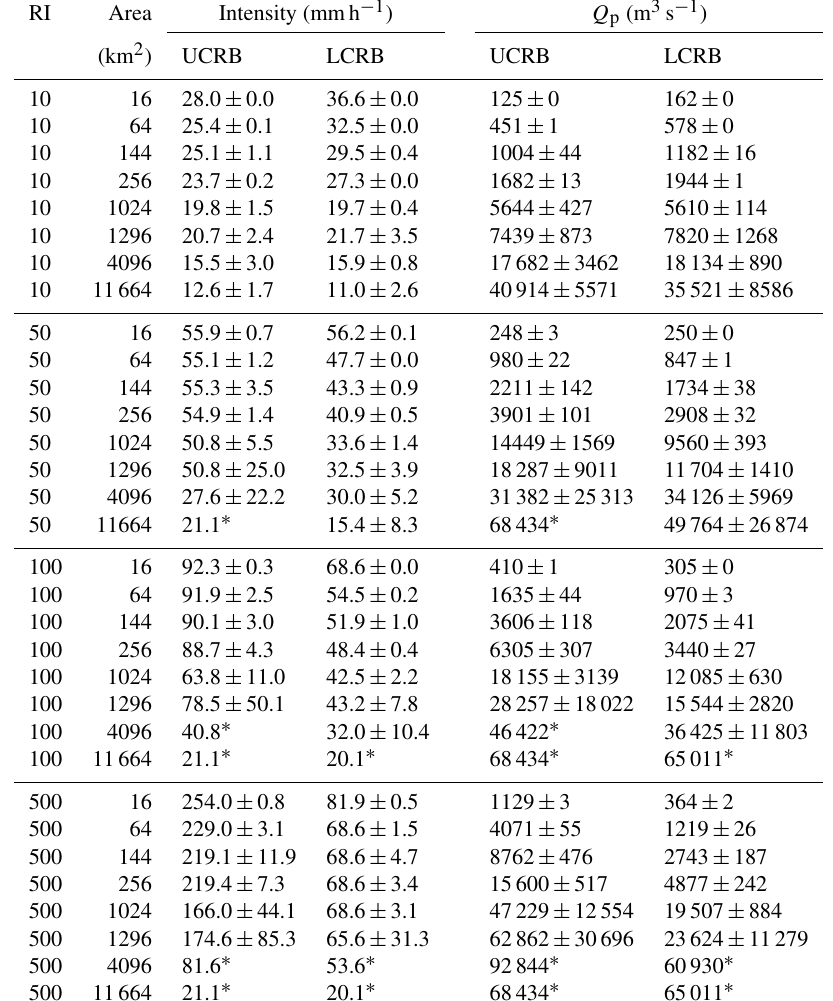
Table 1. Maximum rainfall intensity and Q p for the Upper Colorado River Basin (UCRB) and Lower Colorado River Basin (LCRB). Note that data are all sampled from time intervals of measurement ≤